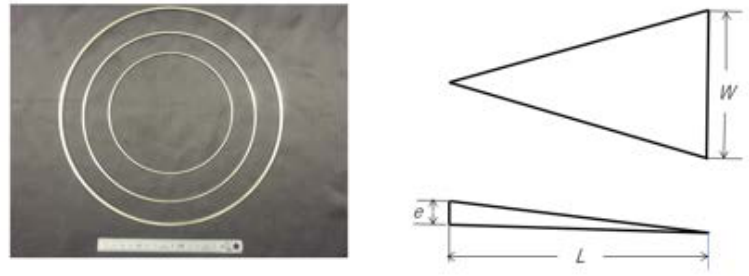
Figure 3. Circular ribs and vortex generator. Table 2. Dimensions of VGs.